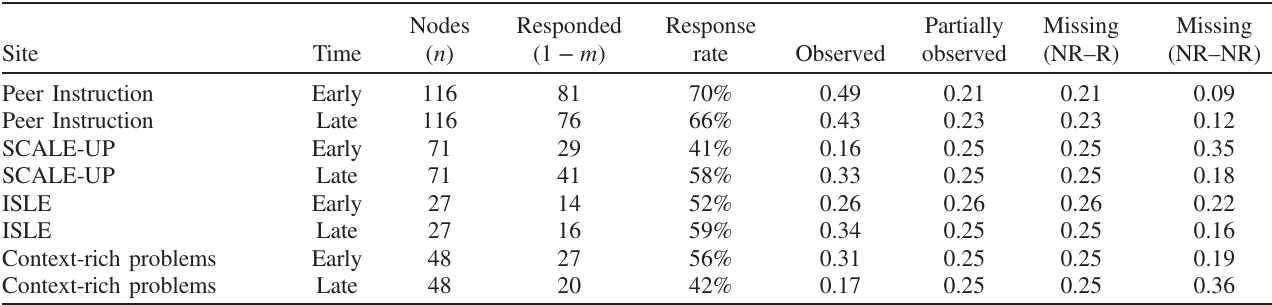
TABLE I. Survey response rates and proportions of observed and unobserved ties for the sections analyzed in this